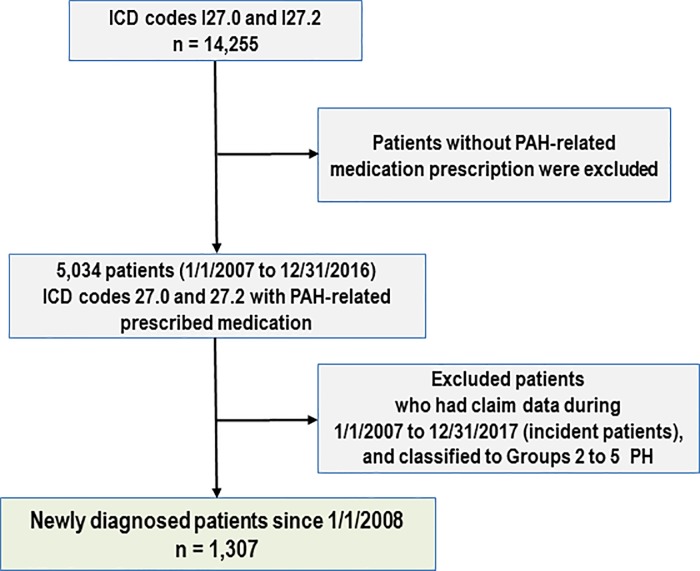
Inclusion flow diagram of newly diagnosed pulmonary arterial hypertension patients enrolled in the study.PAH, pulmonary arterial hypertension; ICD-10, International Classification of Diseases-Tenth Revision.